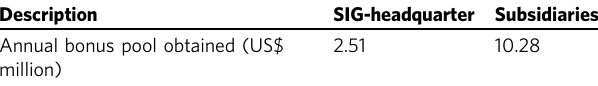
Table 9 Final annual bonus allocation between headquarters and subsidiaries.